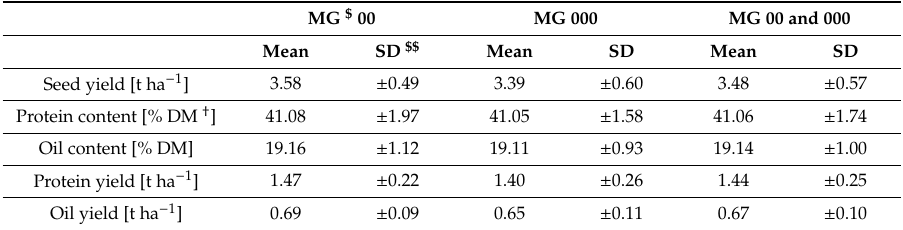
Table 5. Soybean seed yield (arithmetic means) and seed properties’ means over five locations, 13 varieties and two trial years (2016, 2017) in Germany, p < 0.05.